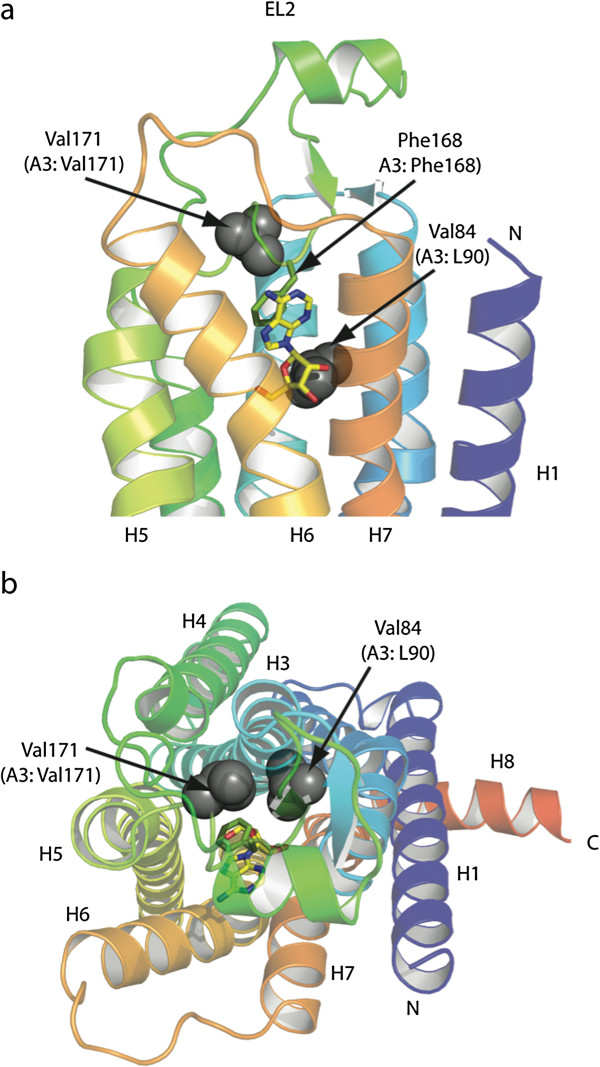
Structure of the A2a adenosine receptor identifying corresponding positions of Leu90 and Val171 residues in the A3 receptor. The structure of the thermostabilized A2a receptor, A2aAR-GL31 (PDB code 2YDO), is depicted as a cartoon in rainbow coloration (N-terminus in blue, C-terminus in red), viewed either (a) parallel to the membrane plane or (b) from the extracellular surface perpendicular to the membrane plane. The endogenous ligand adenosine is shown as a stick model (C, yellow, N, blue, O, red) as is the side chain for Phe168 (C, green). The transmembrane helices are labeled H1-H7, the extracellular loop 2 (EL2) is indicated and H8 is the C-terminal amphipathic helix lying parallel to the membrane plane. A3AR residues Leu90 and Val171 correspond to Val84 and Val171 in A2aAR, and they are both shown as space-filling models (grey).